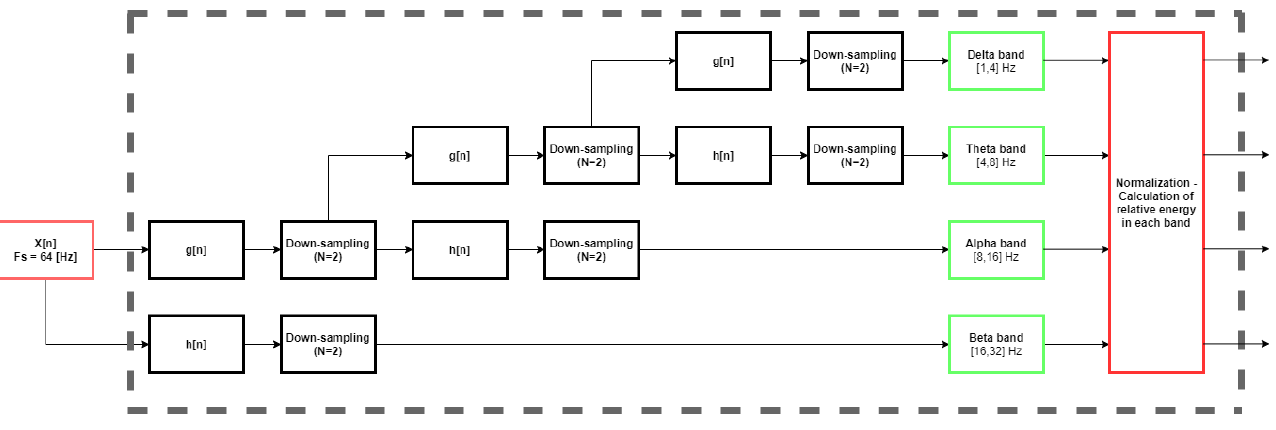
Figure A2. EEG relative band calculation using DWT.